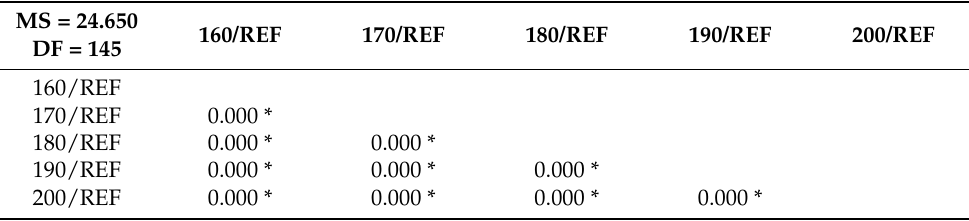
Table A7. Duncan ´ s multiple range test for changes in brightness.